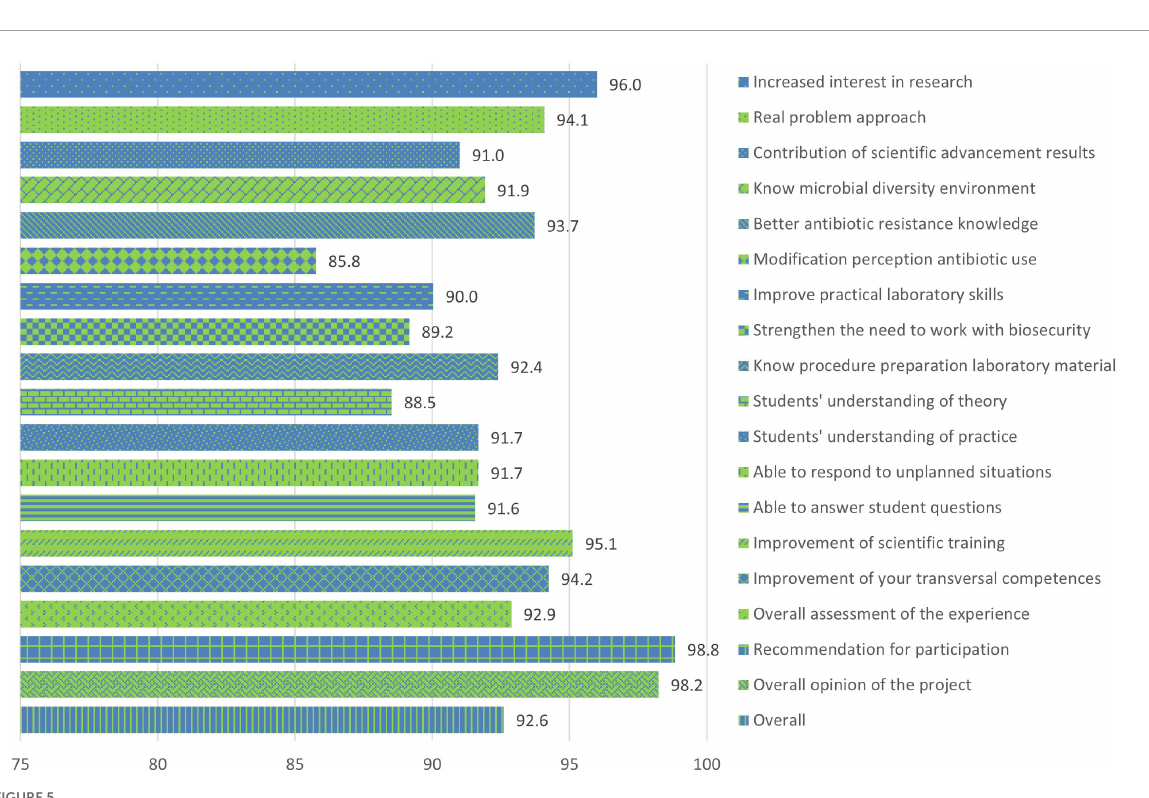
FIGURE5 Percentages of the average satisfaction values of each issue in university students at the end of the SWICEU project during the 2017–2021 academic